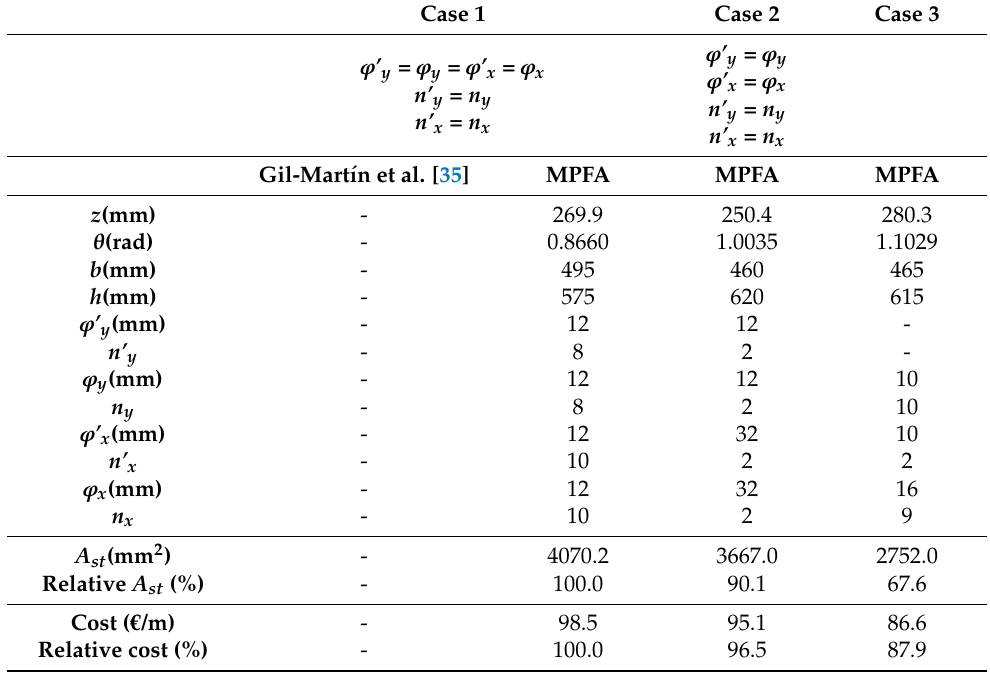
Table 6. Optimal design solutions with variable section.